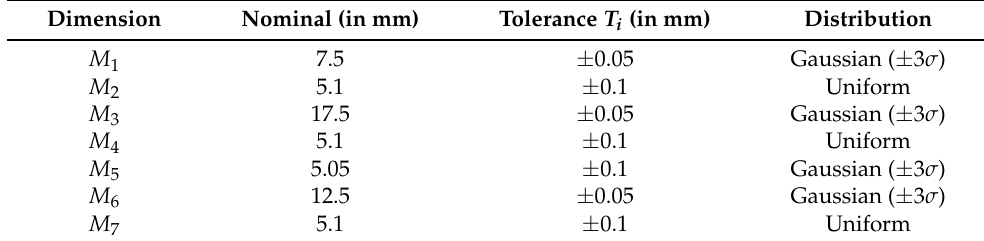
Table 2. Dimensions and corresponding tolerance specifications.